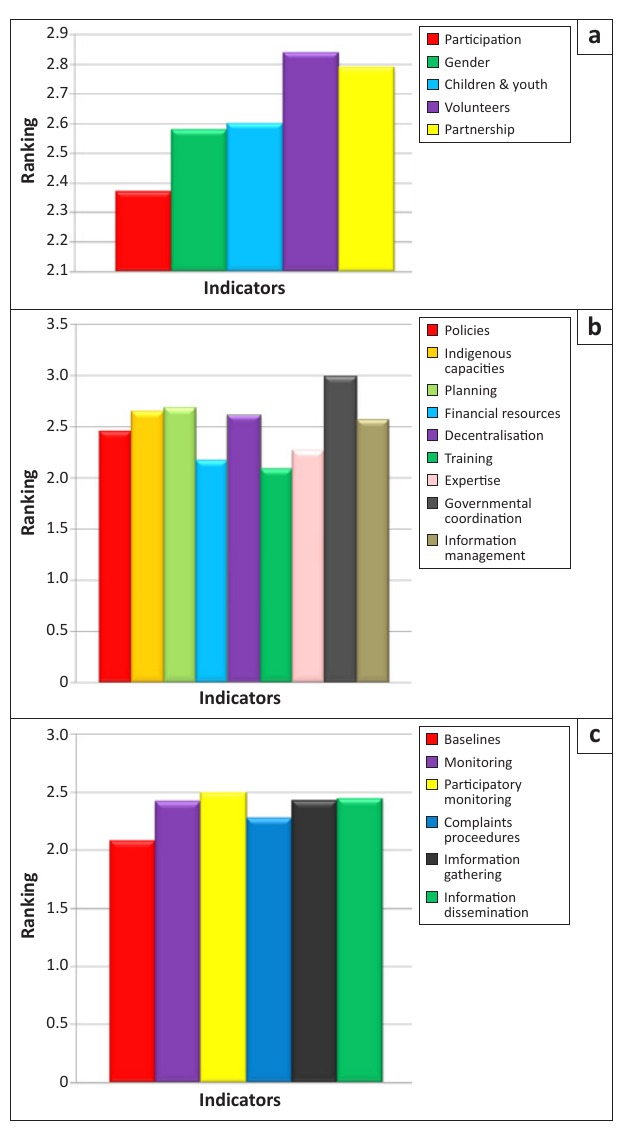
FIGURE 5: (a) Indicators of Inclusion and participation. (b) Indicators of Capacity and Capability. (c) Indicators of Accountability and